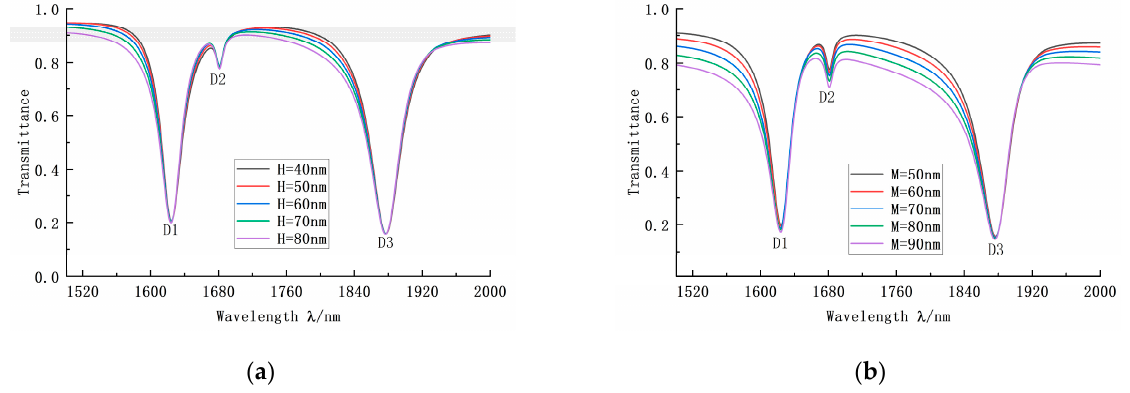
Figure 7. ( a ) Transmission curves of the IZRR structure with different short tube widths. ( b ) Trans- mission curve of the IZRR structure at different short tube heights.